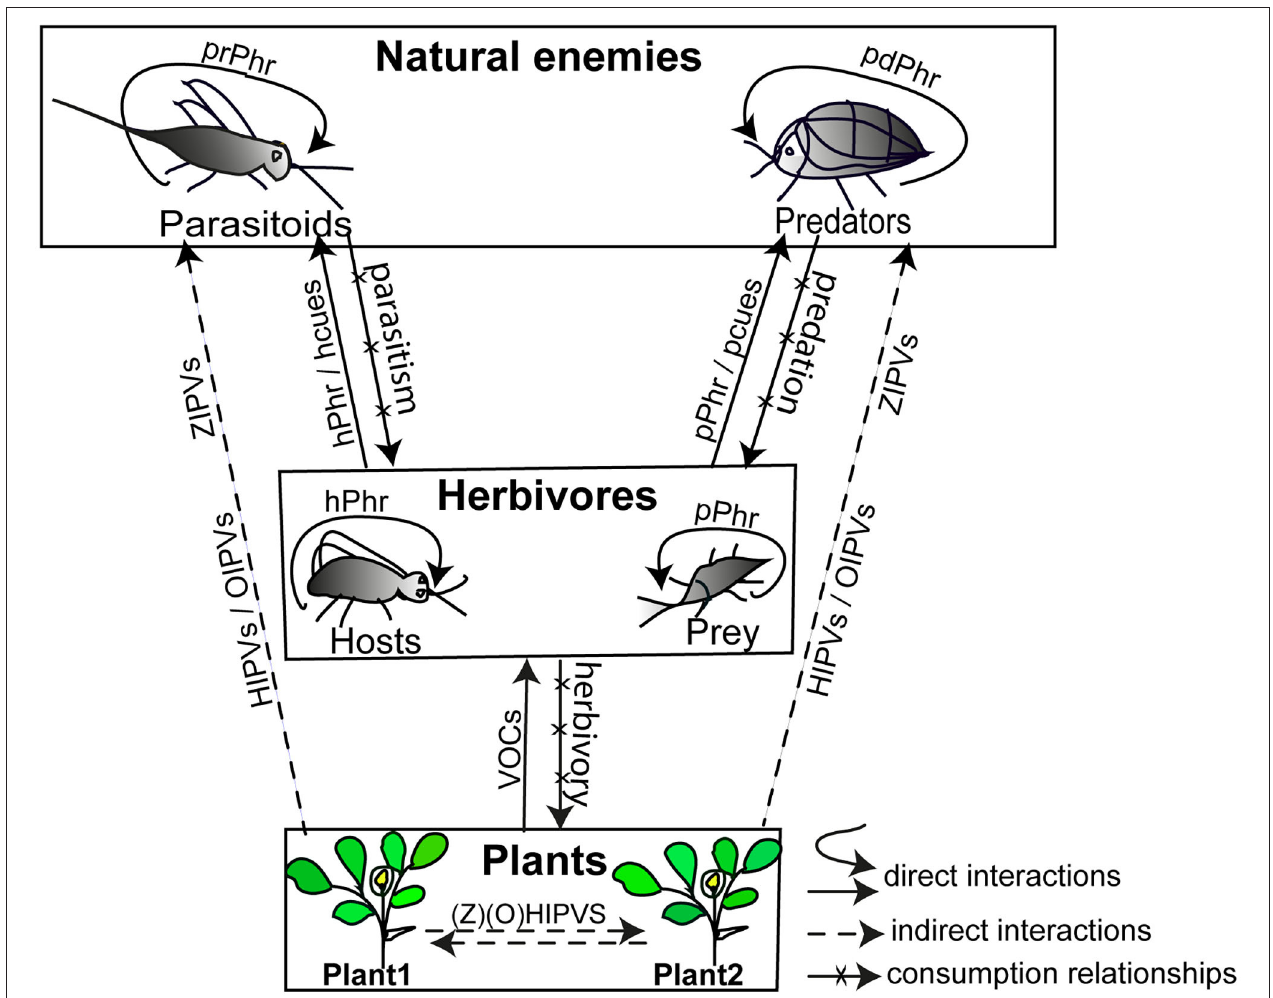
FIGURE 1 | Typical examples of above ground chemical interactions in a tri-trophic system. Solid and dotted lines represent kairomone-based direct and indirect interactions, respectively, in which the arrow bearing the kairomone is directed from the emitter to the receiver. The solid curves indicate pheromone-based direct interactions in which male and female individuals can be an emitter and/or a receiver. HIPVs, herbivory-induced plant volatiles; OIPVs, oviposition-induced plant volatiles; ZIPVs, zoophytophagous-induced plant volatiles; VOCs, volatile organic compounds; pPhr, prey pheromone; hPhr, host pheromone; pdPhr, predator pheromone; prPhr, parasitoid pheromone; pcues, prey-associated chemical cues; hcues, host-associated chemical